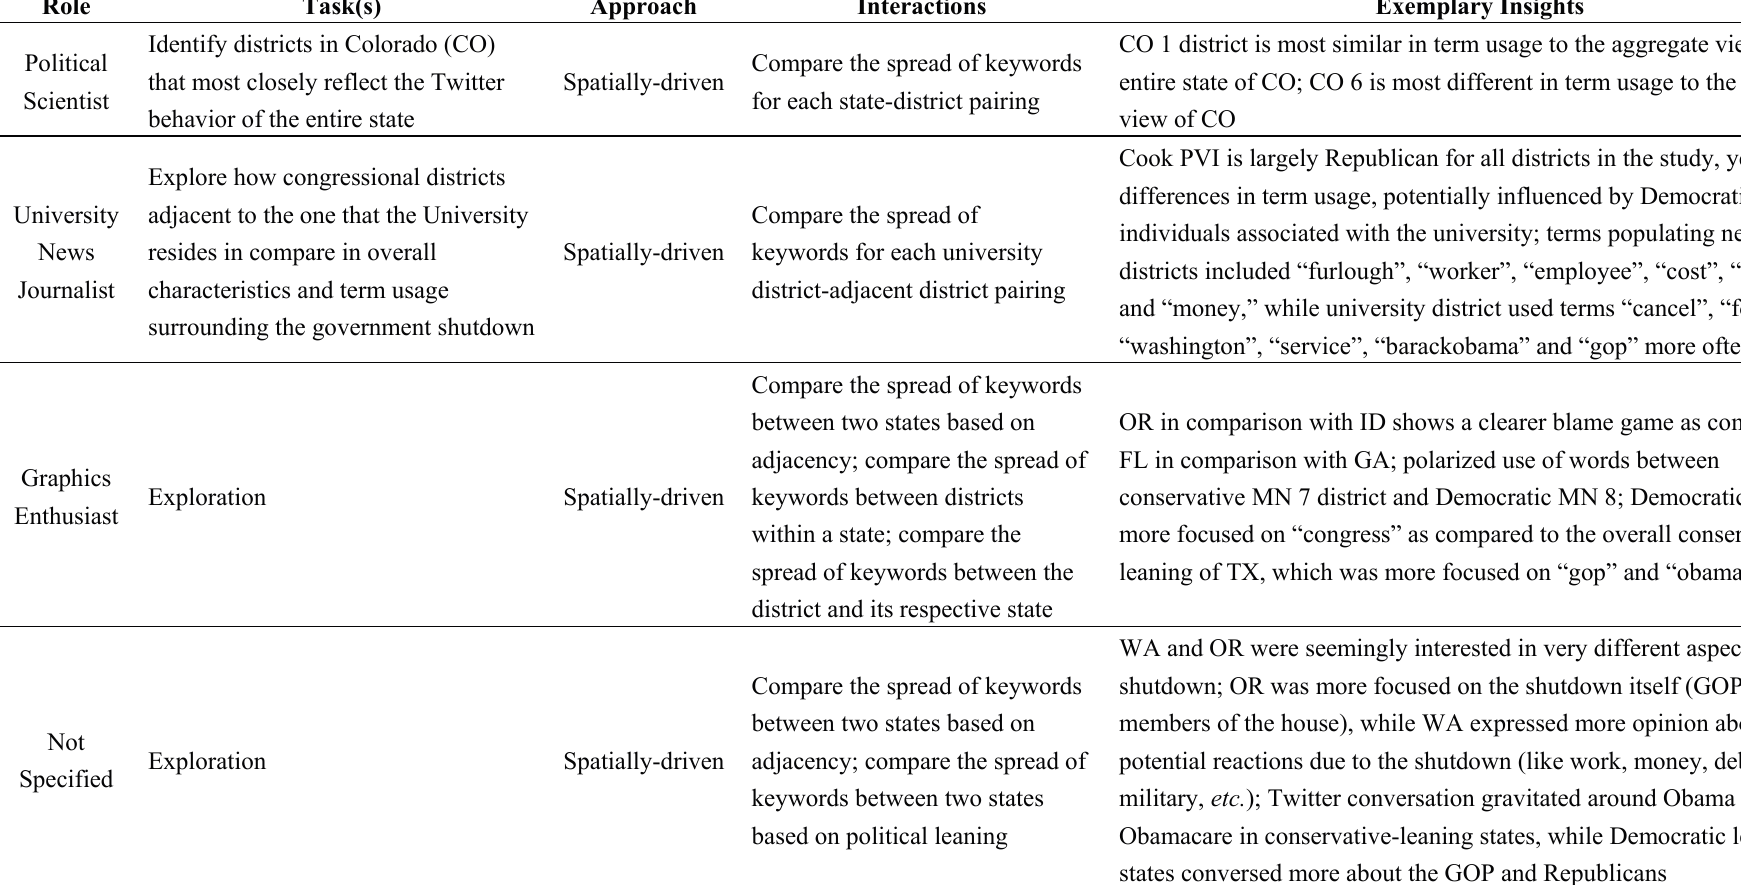
Table 4. Spatially-driven approaches to insight